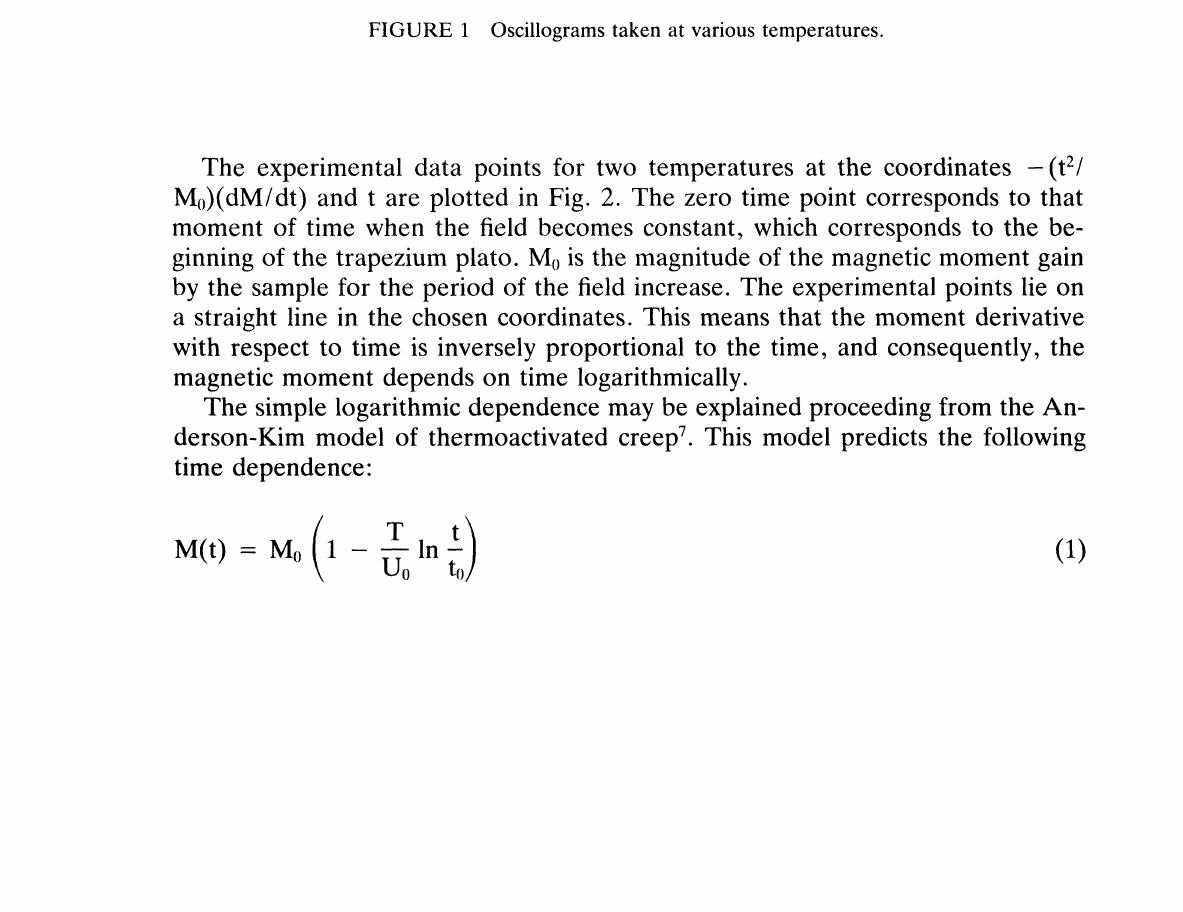
FIGURE Oscillograms taken at various